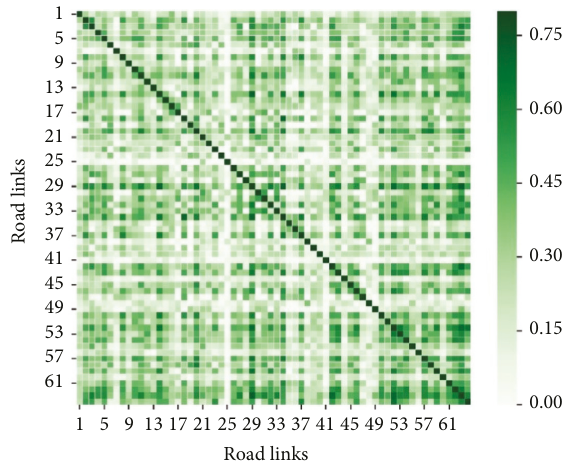
Figure 10: Spatial dependency analysis of the urban